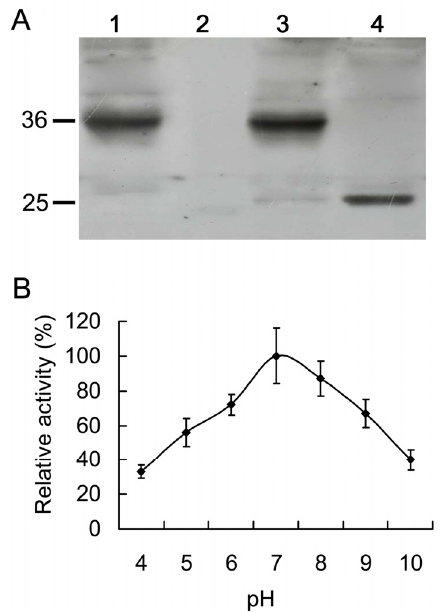
Figure 3. Protein purification and proteolytic activity of AcCP2 expressed in yeast. ( A ) Immuno-detection of recombinant His-AcCP2 protein. Lane 1: AcCP2 crude proteins extracted from yeast containing the pPIC9K-His- AcCP2 vector; Lane 2: crude proteins extracted from yeast containing the pPIC9K empty vector; Lane 3: protein purification by Ni-NTA beads from yeast containing the pPIC9K-His- AcCP2 vector; Lane 4: the purified protein incubated at pH 4.3; and ( B ) Activity was measured on 1% Bz-Phe-Val-Arg-NH- Mec solution containing 15 mM AcCP2 proteinase under different pH. Data points represent the mean values of three replicates ± SE ( n = 3).